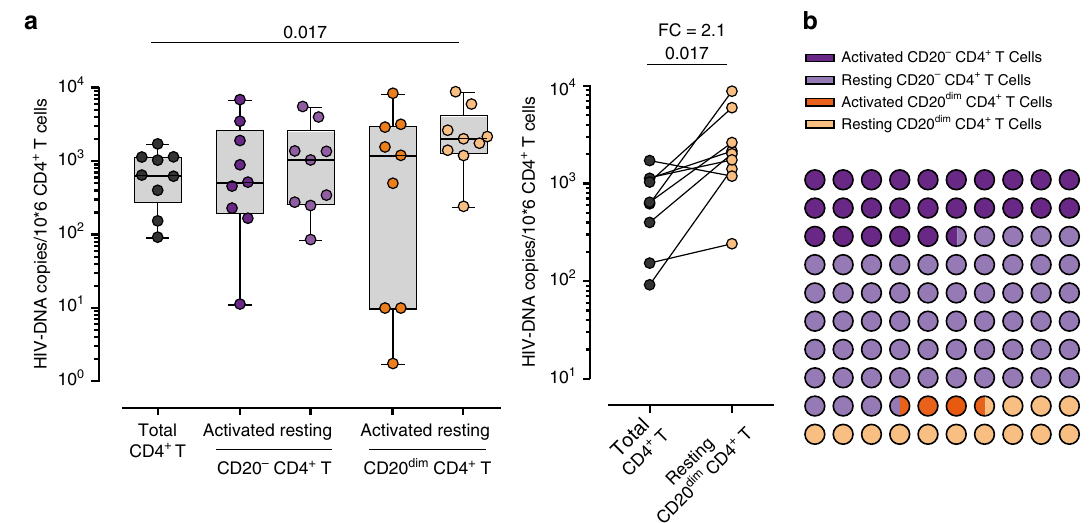
Fig. 3 HIV-1 DNA quanti fi cation in CD20 dim CD4 + T cells. HIV DNA was measured in sorted CD4 + T cells (black), activated CD20 − CD4 + T cells (dark violet), resting CD20 − CD4 + T cells (light violet), activated CD20 dim CD4 + T cells (dark orange), and resting CD20 dim CD4 + T cells (light orange) in PBMCs from nine ART-suppressed patients. The activation state was de fi ned by the expression of HLA-DR, CD69 or CD25 markers. a Copies of viral DNA molecules per 10 6 CD4 + T cells are represented for all sorted populations (left panel). Medians and min – max rank are represented. Comparison of HIV DNA copies per 10 6 cells between CD4 + T cells and resting CD20 dim CD4 + T cells with the fold-change (FC, right panel). Comparisons were performed using the Wilcoxon test. b Contribution of each cell population to the total pool of HIV DNA. In panels ( a ) and ( b ), data from patients #11 – 14, 19, and 27 – 30 are shown. Data underlying this Figure are provided as Source Data fi